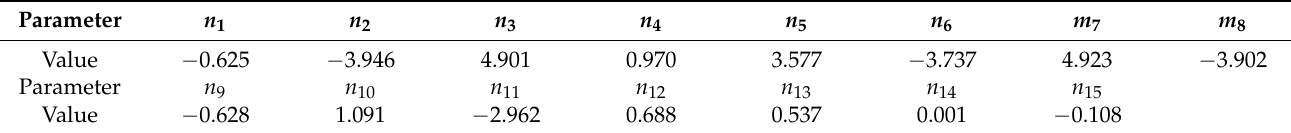
Table 7. Fitting results of the damping coefficient a 1 .